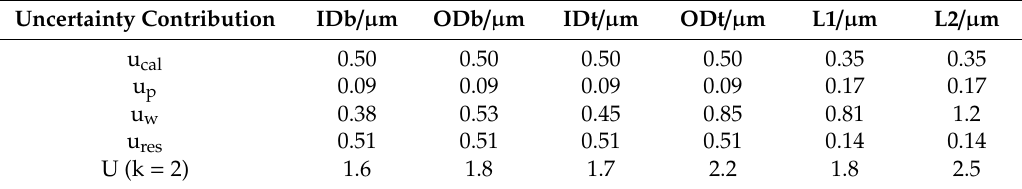
Table 3. Average uncertainty contributions and expanded uncertainty U for the µ IM